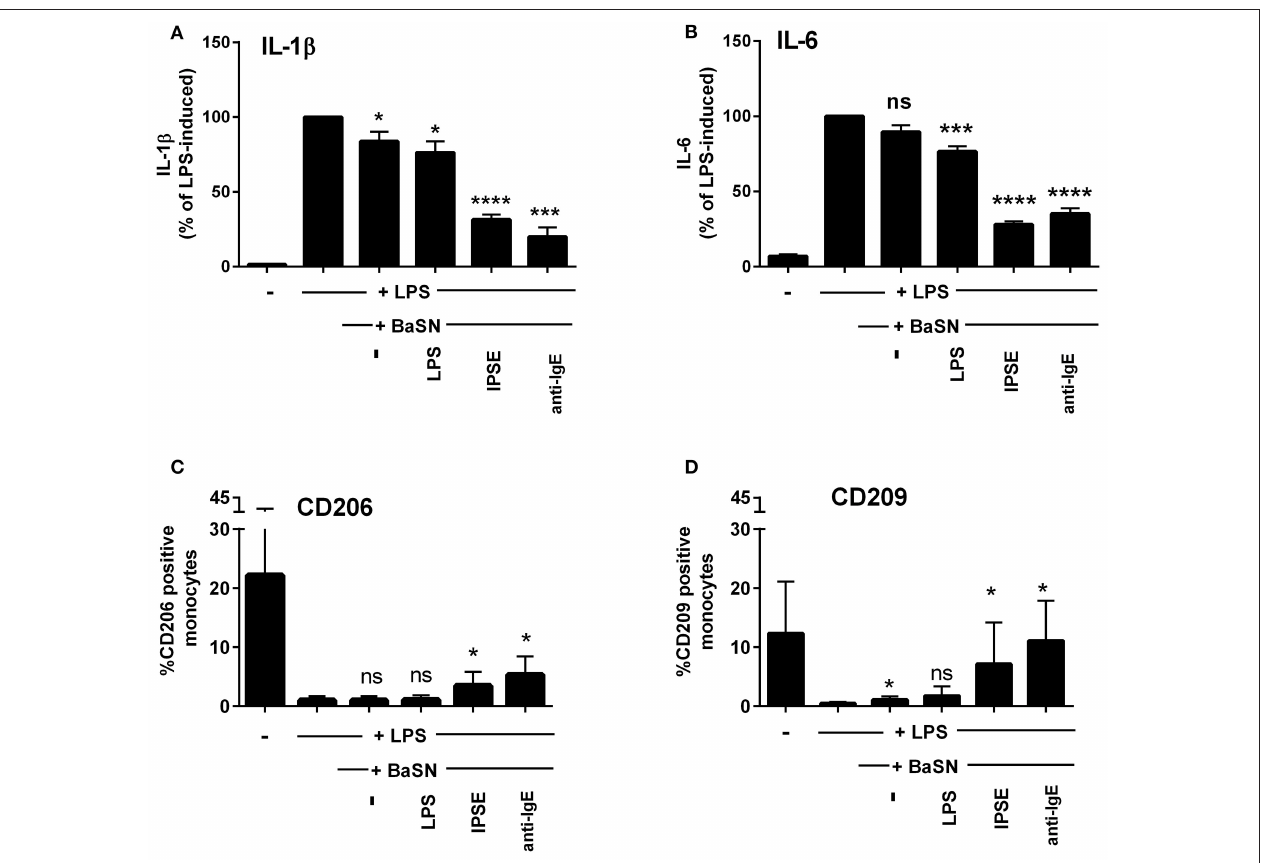
FIGURE 4 | Culture of LPS-activated monocytes in supernatant from IPSE/alpha-1-stimulated basophils resulted in inhibition of pro-inflammatory cytokine release and increased numbers of CD206- and CD209-positive monocytes. IL-1 β (A) and IL-6 (B) release from monocytes, and CD206 (C) and CD209 (D) expression on monocytes cultured with supernatant from basophils (BaSN). Monocyte-derived cytokine release was normalized to the maximum release following LPS activation (100%). Data are presented as mean ± SEM, n = 9 (anti-IgE: n = 5). Statistics were performed by paired t -test; significance was shown for “LPS with BaSN” vs. “LPS without BaSN” (black bar); * p < 0.05, *** p < 0.001, **** p <